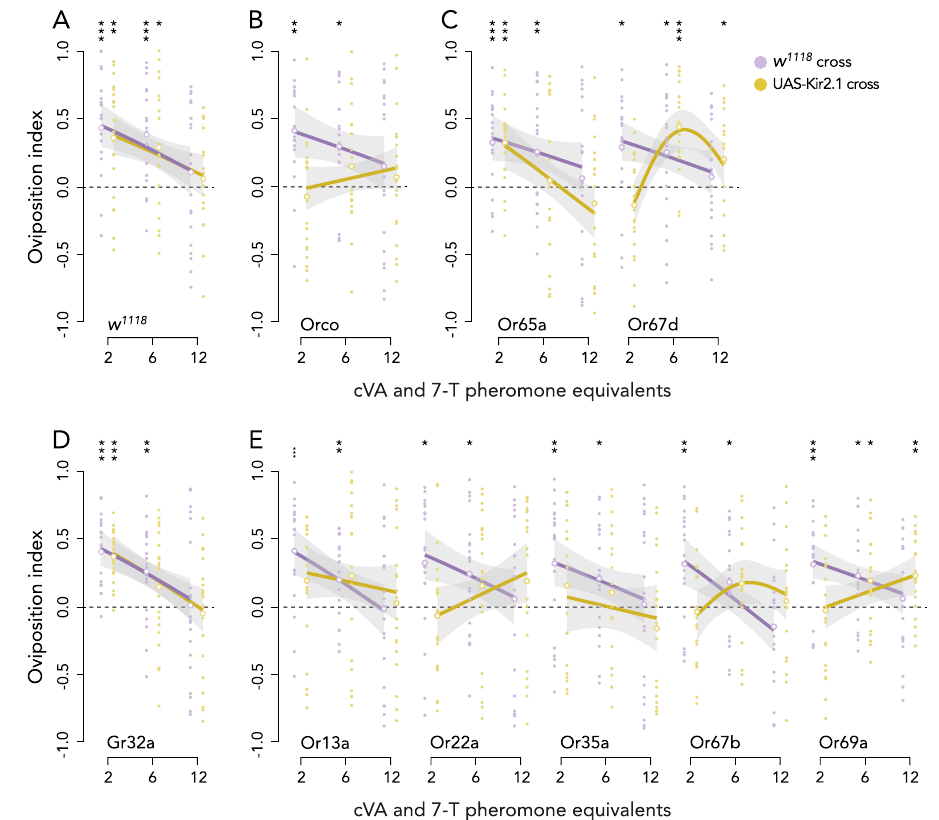
Fig. 4 | Candidate receptors involved in the dose-dependent detection of cVA and 7-T or heptanal. A Oviposition preference to two, six and twelve times the single fl y pheromone equivalent of cVA (560 – 1680 – 3360ng) combined with 7-T (280 – 840 – 1680 ng) for w 1118 control femalescrossed to w 1118 (purple)orcrossed to UAS-Kir2.1 (ochre). Oviposition preference of control females and females with silenced receptors for B Orco; C olfactory receptors Or65a and Or67d for cVA; D gustatory receptor Gr32a for 7-T; E olfactory receptors Or13a, Or22a, Or35a, Or67b,andOr69aforheptanal.Thenon-linearanalysis( fi ttedwithGAM)andlinear analysis ( fi tted with GLM) are visualized with their 95% con fi dence intervals (gray shaded area). The individual replicates are visualized by the small data points and the mean oviposition indices are given by larger un fi lled data points. These data